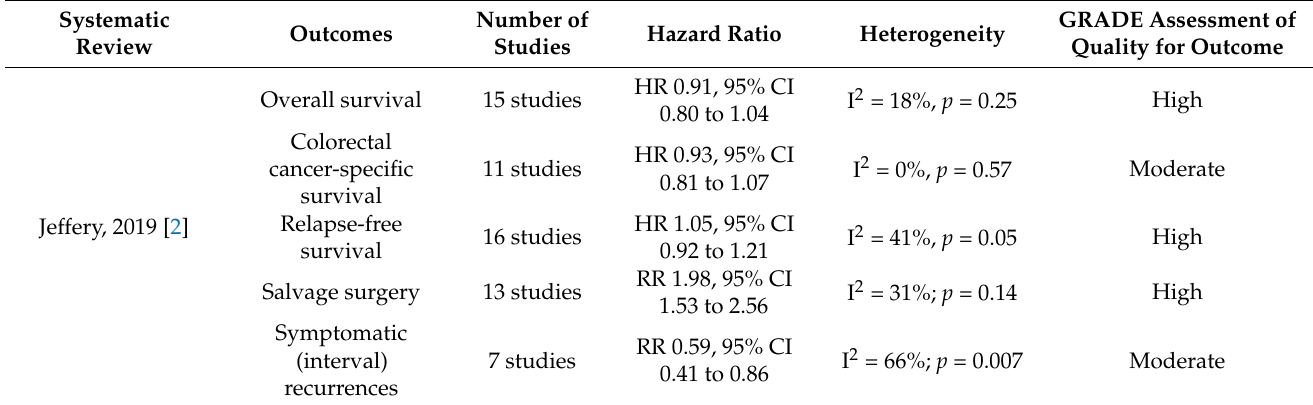
Table A1. Results of Jeffery et al. meta-analysis, high- versus low-intensity follow-up.